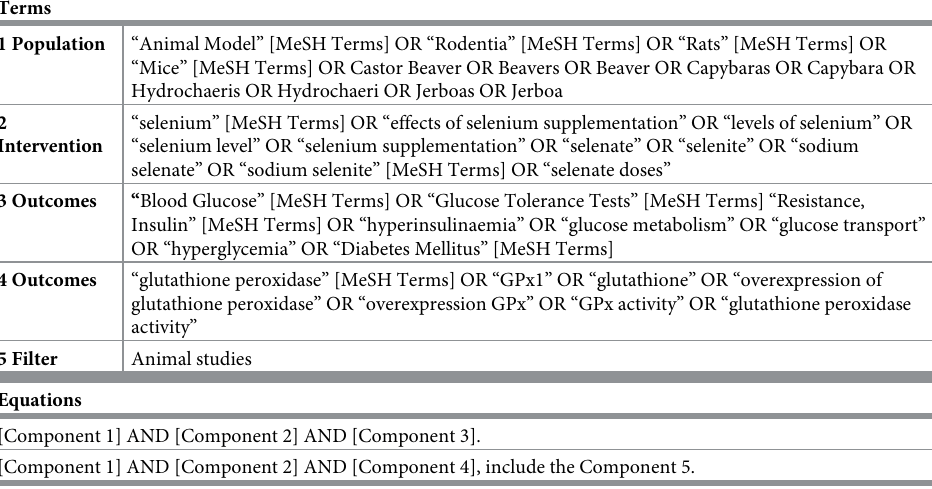
Table 3. Search strategy applied to PubMed and